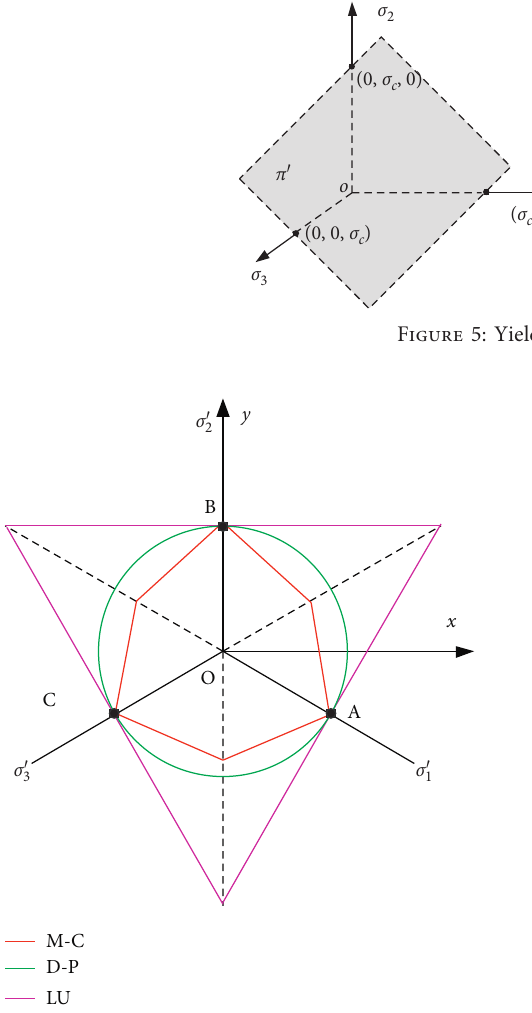
Figure 6: Yield curves of different criteria on π ′ -plane.